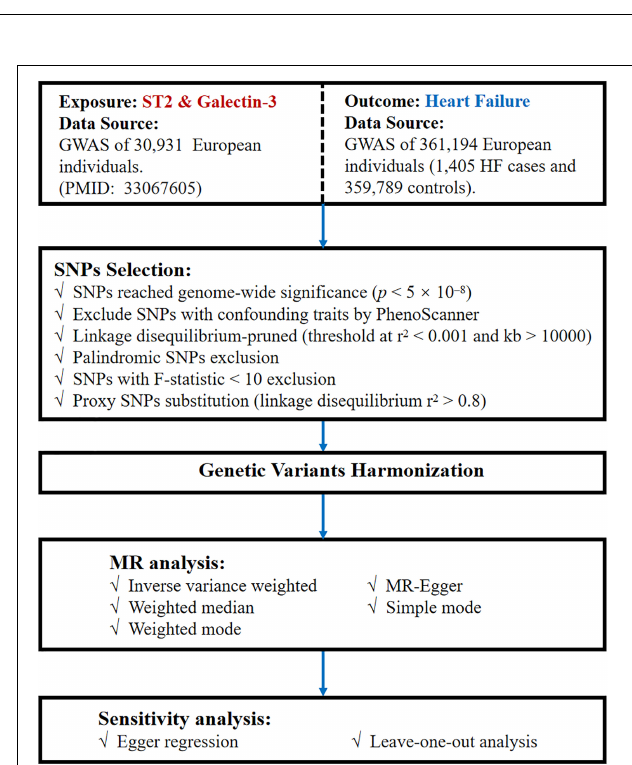
FIGURE 2 | Flow chart of our MR study. MR, Mendelian randomization; GWAS, genome-wide association study; SNPs, single-nucleotide